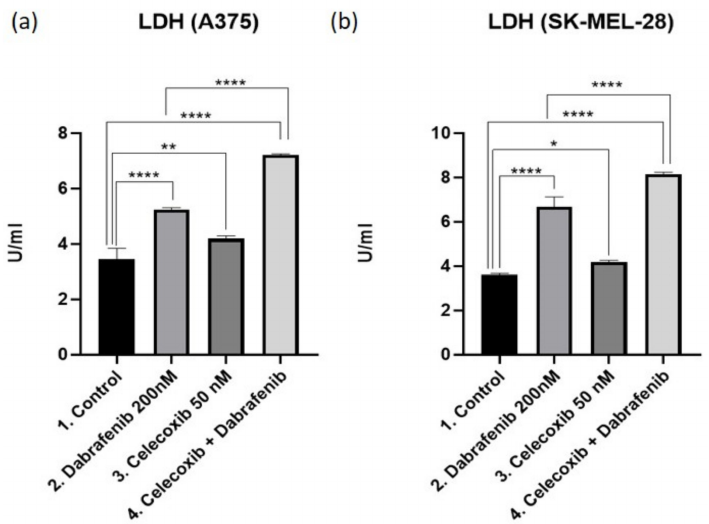
Figure 5. LDH as a marker for cell membrane integrity. LDH levels were measured in both A375 ( a ) and SK-MEL-28 ( b ) cell culture medium as a result of the cytotoxic effect of the drugs used. Results were statistically analyzed using GraphPad Software, Ordinary One-way ANOVA test, Multiple comparisons. Each bar represents mean ± standard deviation, n = 3. * = p < 0.05, ** = p < 0.01, **** = p <